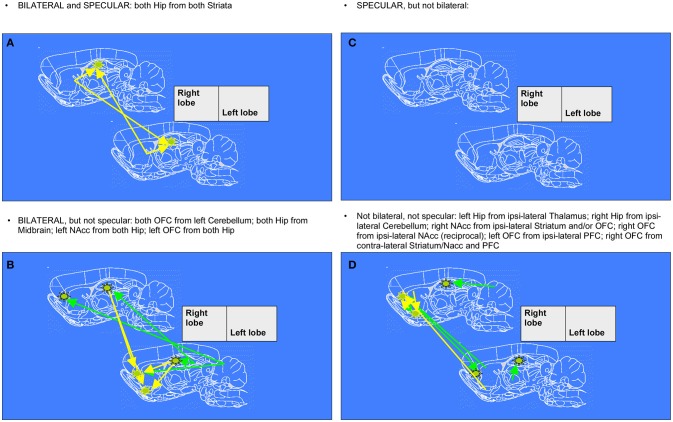
Diagrams denoting increased connections between “early” and “mid” age stages in rat brain (juvenile transition). Rat brain atlas diagrams (Paxinos and Watson, 1998), corresponding to the center of the MRI slices, are used to plot arrows denoting connections to a seed (see stars) from “target” regions where pixels consistently emerge. This happens when the cross-correlation value in the template for “mid” age stage group is trespassing the corresponding threshold value (for the same pixel) calculated from resampled “early” age stage group (see Figure 1 for an example of difference-from-threshold maps). Arrows denote the regions whose connectivity to that seed (see stars) was enhanced (higher than the 99th percentile of the resampled “early” age stage). (A,C) specular changes (B,D) not specular changes (A,B) bilateral changes (C,D) not bilateral changes (see definitions in Figure 6).